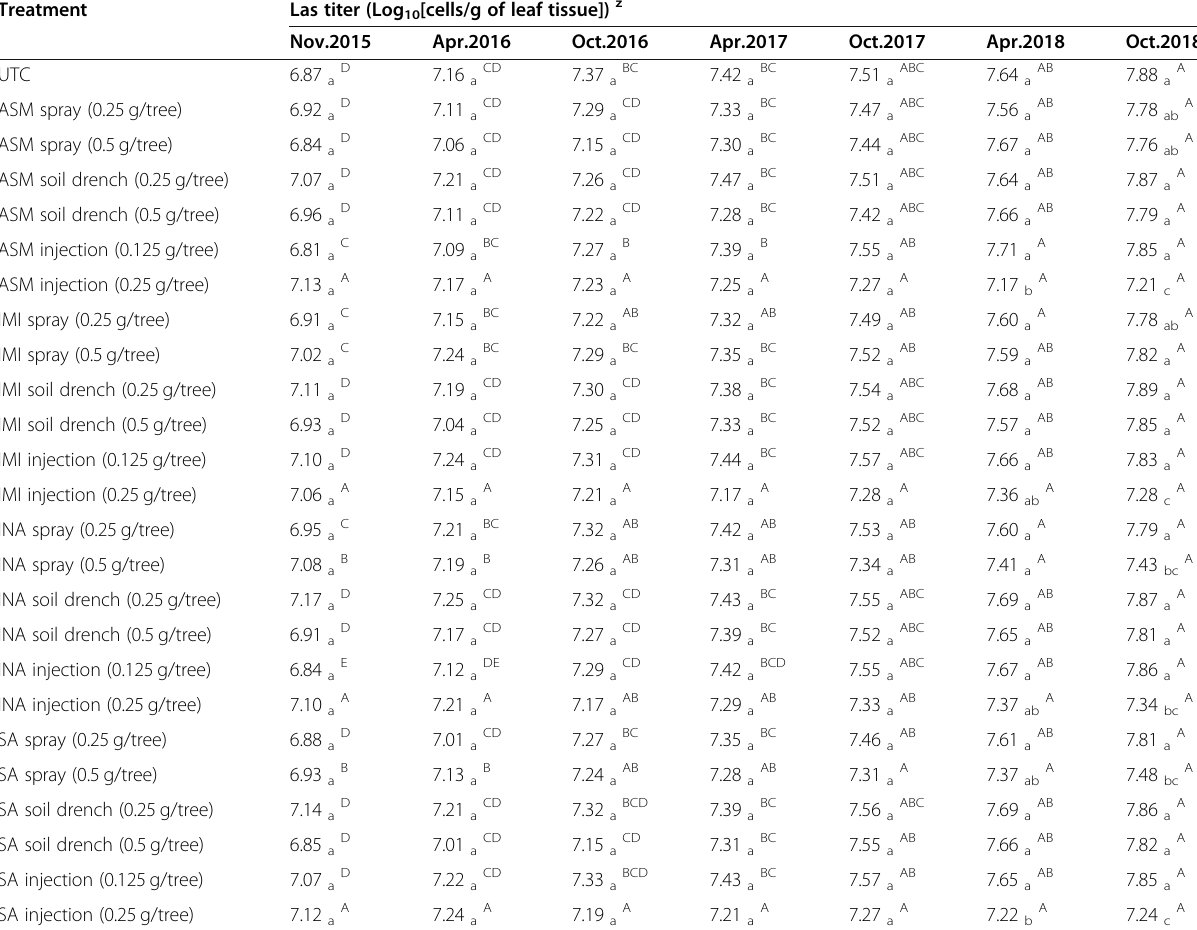
Table 1 Candidatus Liberibacter asiaticus (Las) titers in leaf samples of Hamlin sweet orange trees treated with various SAR inducers in a three-year field trial (2015 – 2018)